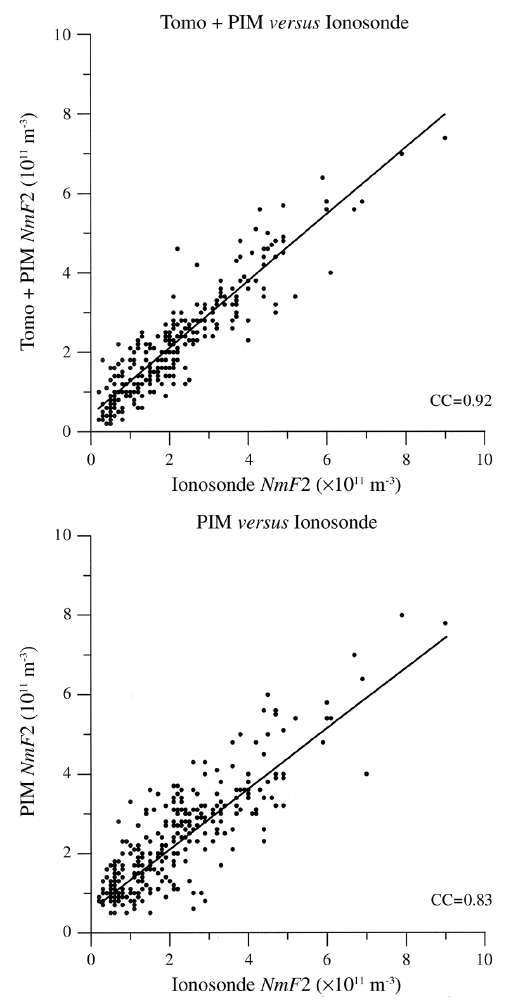
Fig. 5. Correlation of NmF 2 from tomography plus PIM maps ( upper ) and PIM alone maps ( lower ) with corresponding values from ionosondes. From Dabas and Kersley (2003), reproduced by permission of the American Geophysical Union